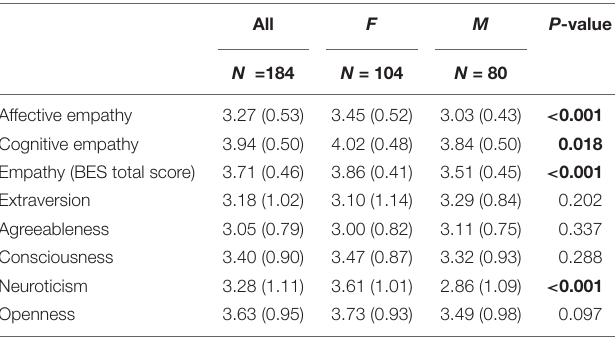
TABLE 2 | Average scores on the measures of empathy and personality traits, overall and by gender. All F M P -value N =184 N = 104 N =